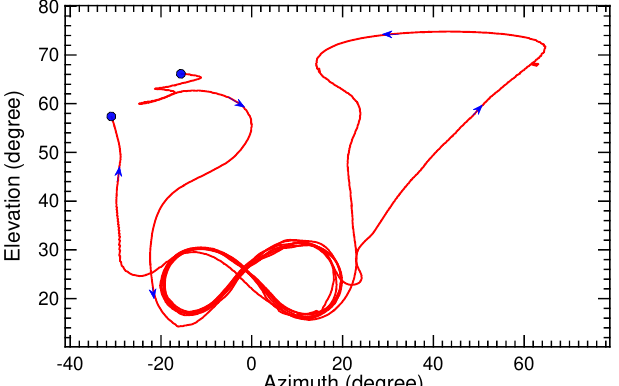
Figure 27. Recorded azimuth and elevation angles for two pumping cycles.